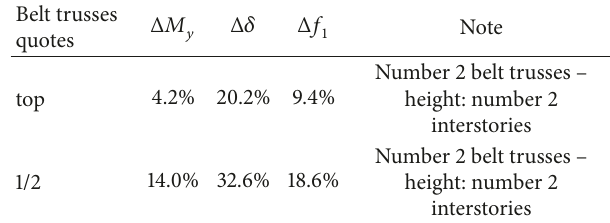
Table 11: Effects of belt-truss location of the